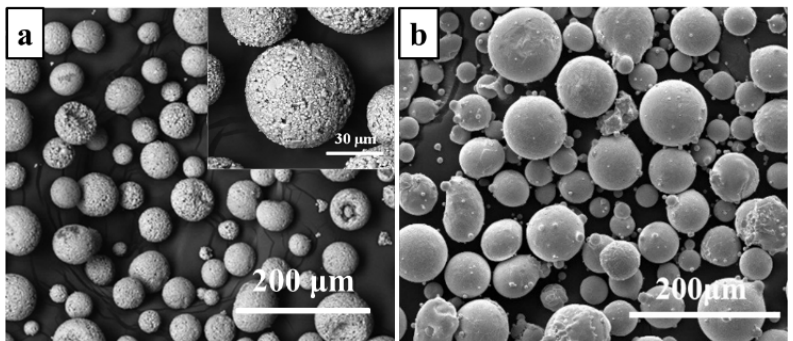
Figure 2. SEM images of (Y 0.8 Gd 0.2 ) 3 Al 5 O 12 ( a ) and NiCrAlY ( b ) powders for